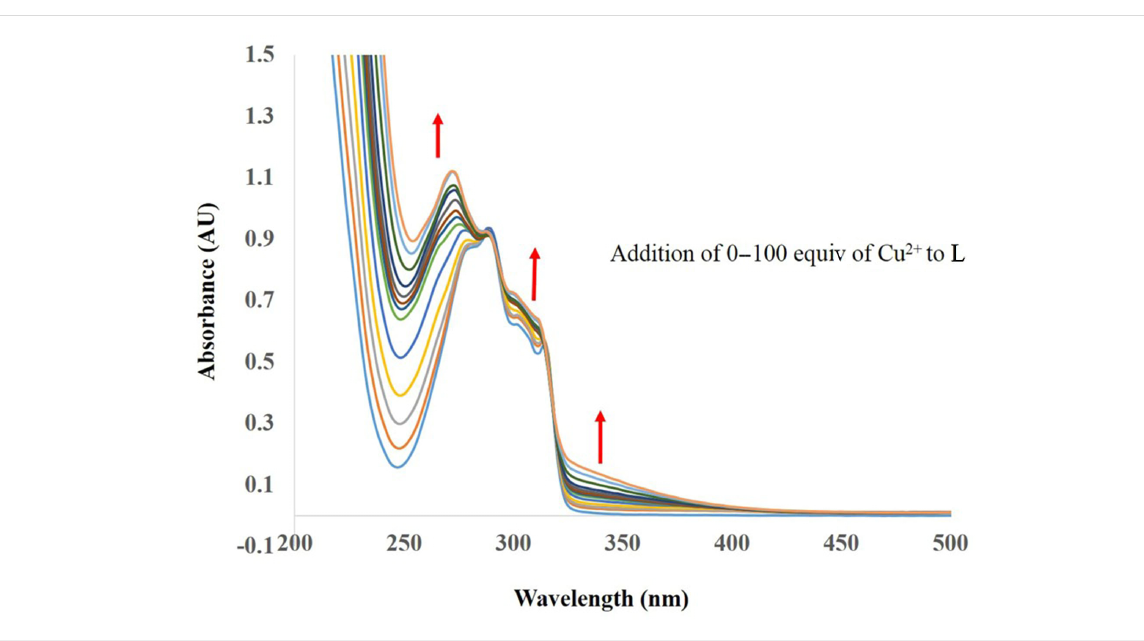
Figure 3: Influence of the addition of increasing amounts (0–100 equiv) of Cu 2+ on the absorption spectra of L (1.0 × 10 − 5 M) in MeCN.